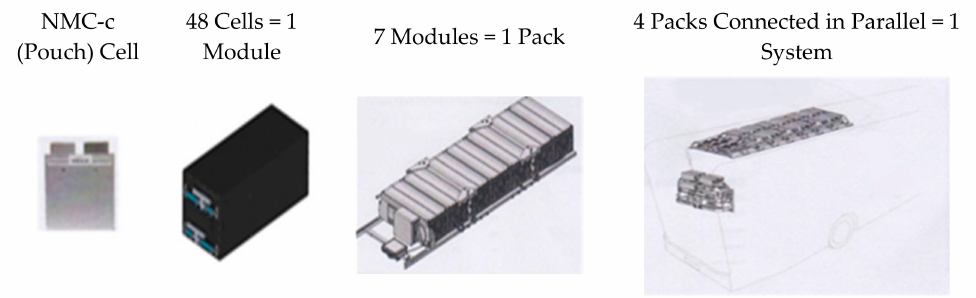
Figure 7. The installations of the NMC-c (pouch) type LIB.